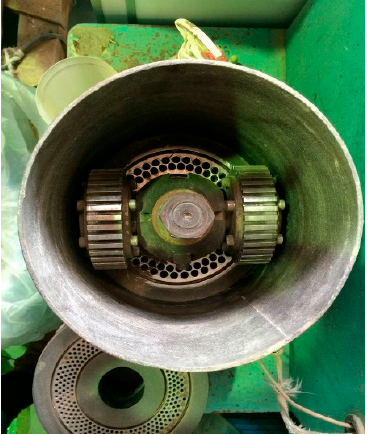
Figure 2. Flat die pellet machine.